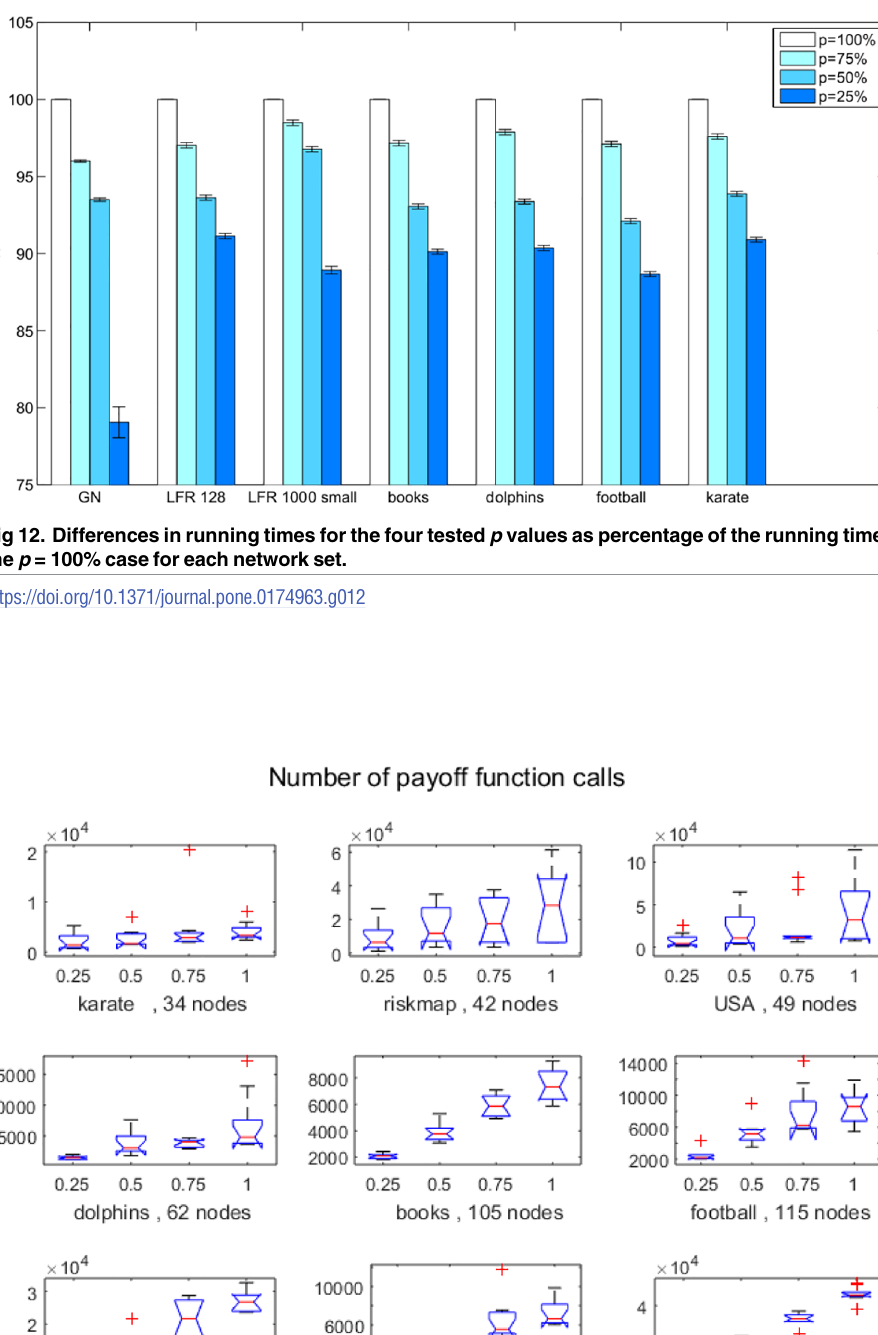
PLOS ONE | https://doi.org/10.1371/journal.pone.0174963 May 3,